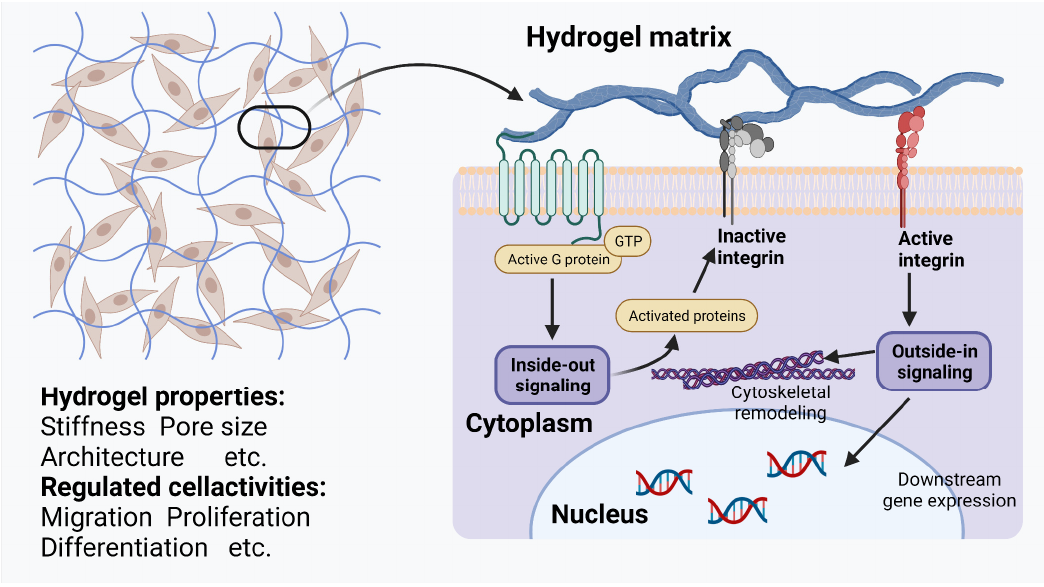
Figure 2. Schematic representation of the communication between hydrogel and the cell. Modulation of various modifiable physicochemical properties of the hydrogel can act on cell surface receptors (such as α 1 β 1 and α 2 β 1 integrins [23] and CD44 [24], and depends on the type and physicochemical properties of the hydrogel) and thereby modulate intracellular signal transduction pathways (such as STAT3 [24]). This figure was created with BioRender, accessed on 1 December 2022 (https://biorender.com/).